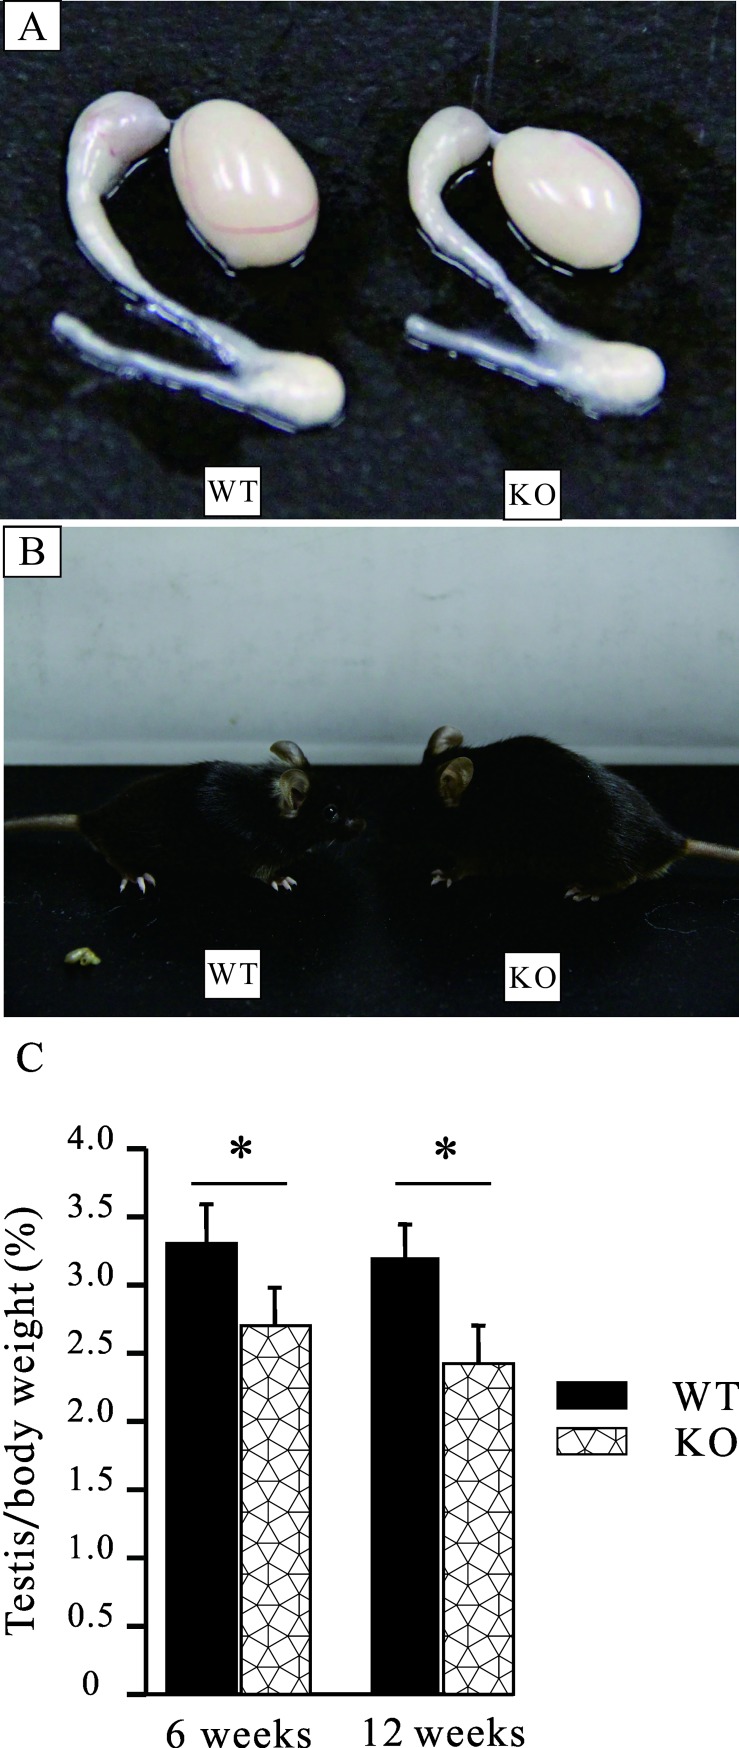
Analysis of male reproductive organs in MTMR14-/- mice.(A) Representative examples of whole-mount preparations of reproductive organs from WT and MTMR14-/- mice. (B) Representative photos showing that MTMR14-/- mice are fatter than their littermates. (C) The ratios of testis to body weights at six and twelve weeks were significantly decreased in MTMR14-/- mice (n = 10). *: P < 0.05. These data demonstrated that MTMR14 deficiency alters the normal size of reproductive organs in male mice, suggesting that MTMR14 participates in regulating the growth of male mice, especially the reproductive organ testis.